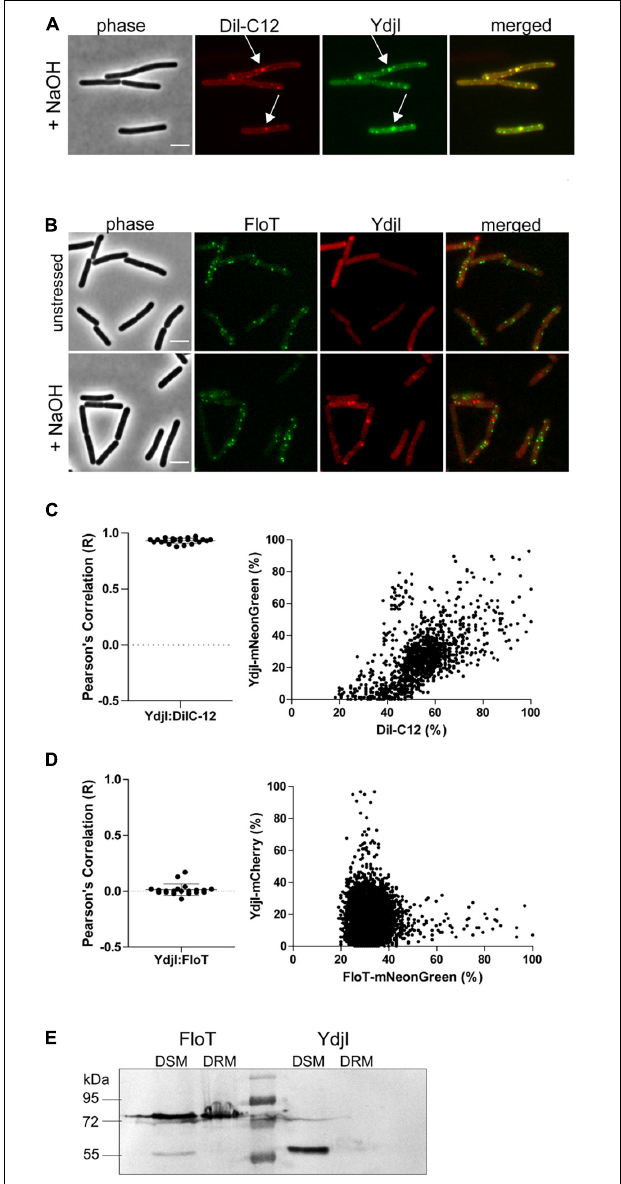
FIGURE 4 | YdjI localizes into fluid membrane regions and does not co-localize with FloT. (A) YdjI co-localizes with fluid membrane regions as indicated by co-localization with Dil-C12 staining (arrows). (B) Localization of YdjI and FloT are independent. Micrograph show no localization of FloT and YdjI in a double tagged strain floT-mNeonGreen; ydjI-mcherry . Cells are in exponentially growing phase under unstressed or alkali stress conditions (15 mM NaOH). Scale bars: 3 µ m. (C) Pearson’s co-localization analysis ( n > 20) and fluorescence intensity correlation graphs (right panel) are shown for the YdjI and Dil-C12 localization. The graph displays a pixel by pixel intensity correlation between Dil-C12 and YdjI-mNeonGreen fluorescence. (D) Pearson’s co-localization analysis ( n > 20) and fluorescence intensity correlation graphs are shown for the YdjI-mCherry and FloT-mNeonGreen localization. The graph on the right displays a pixel by pixel intensity correlation between FloT-mNeonGreen and YdjI-mCherry fluorescence. (E) Localization of YdjI in the detergent soluble membrane fraction (DSM). DSM/DRM extraction using strains expressing YdjI-mCherry (ASB049) and FloT-mCherry (ASB044) and subsequent immunoblotting using anti-mCherry antibodies is